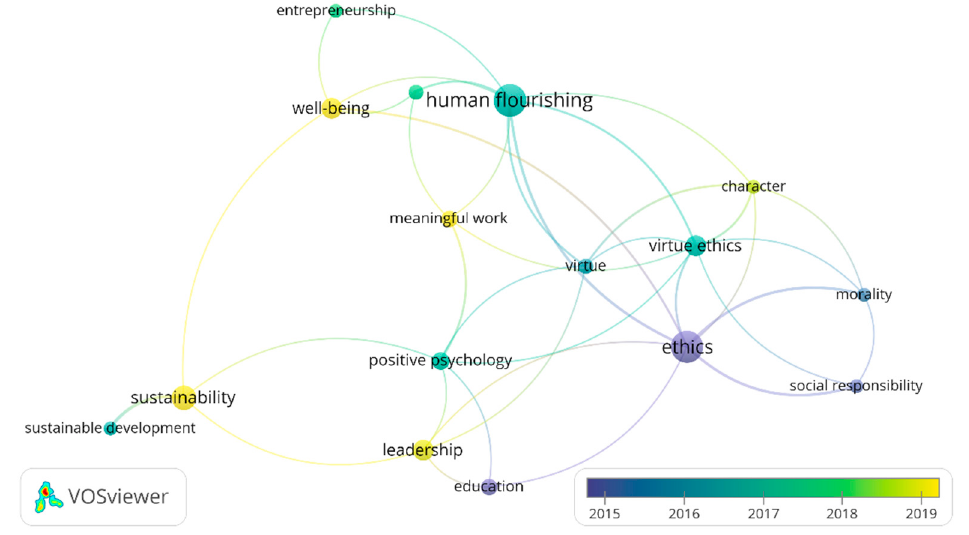
Figure 5. Overlay visualization (human flourishing—SCOPUS).